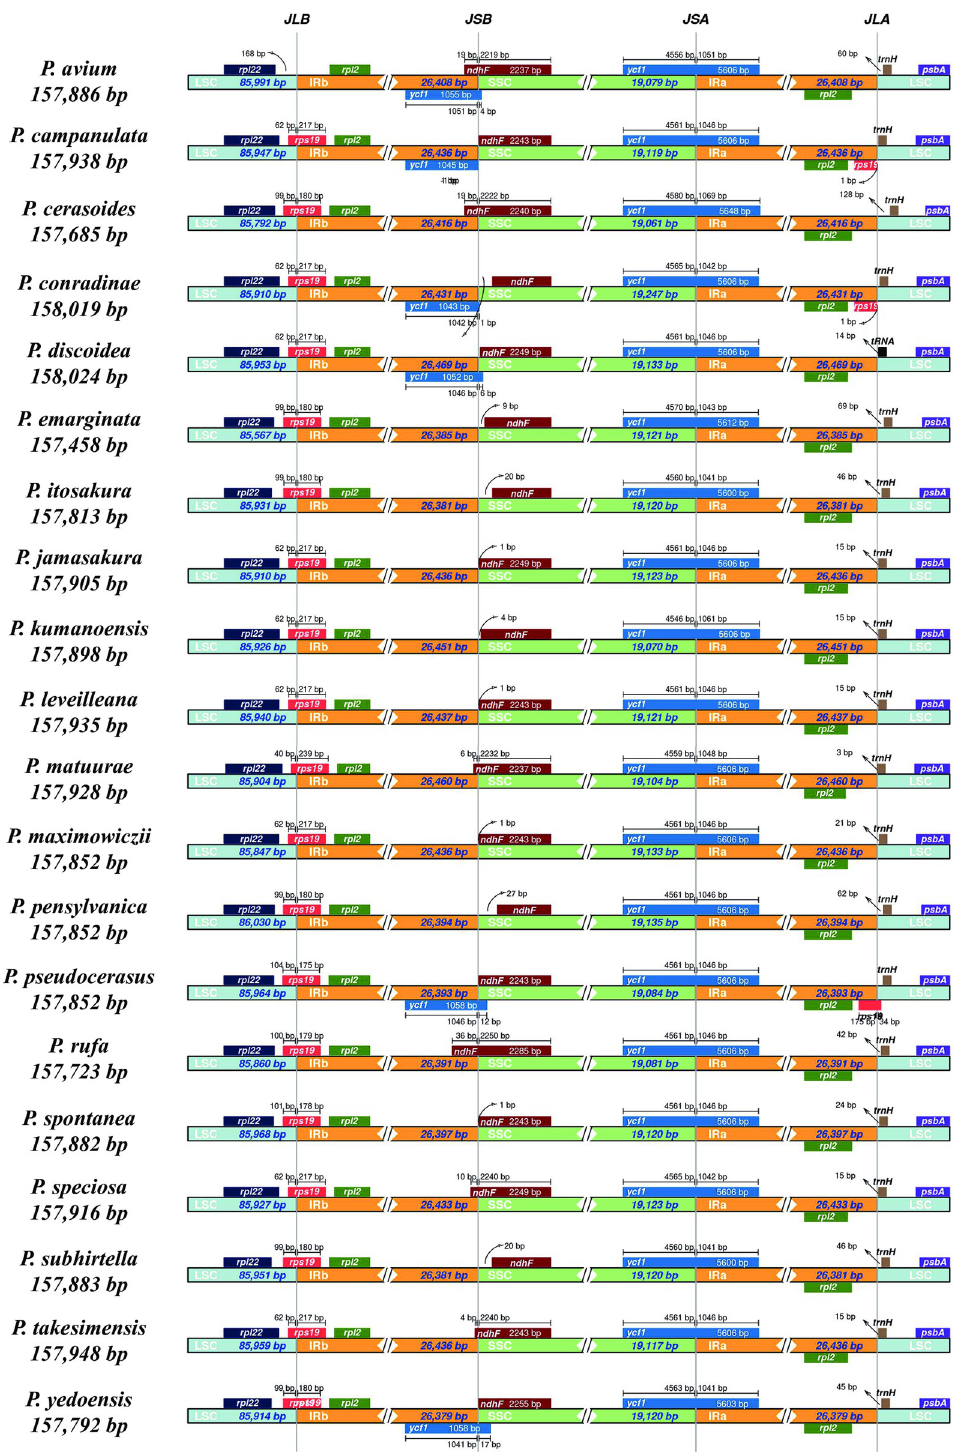
Fig 2. Comparisons of LSC, SSC and IR region boundaries among the plastomes of the 20 subg. Cerasus species studied.